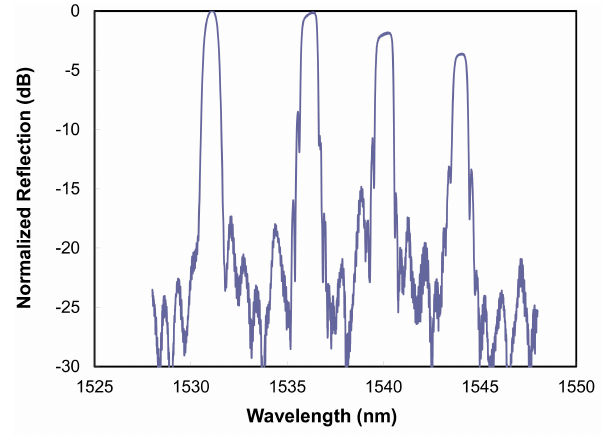
Figure 13. Reflection spectrum of a 4-element Type II FBG sensor array written in 400 µm clad single mode fiber.